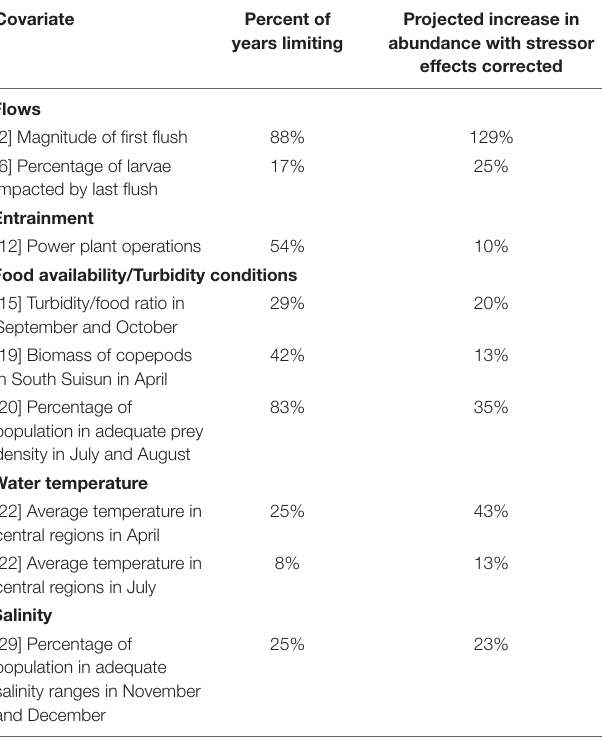
TABLE 4 | Examples of representative model results. TABLE 5 | Covariates that appear to constrain abundance of delta smelt, the percentage of years each covariate constrained abundance, and the projected average abundance change ratio (ACR) if inadequate factor conditions are corrected, therefore no longer